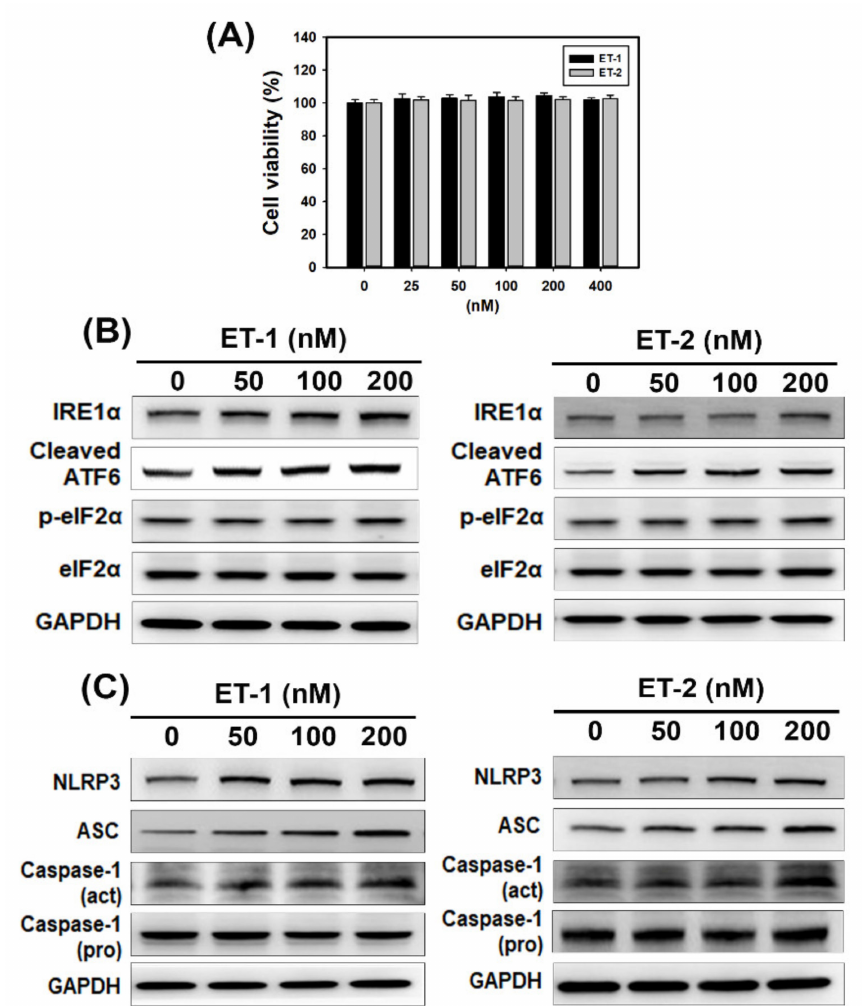
Figure 2. Cell viability, endoplasmic reticulum (ER) stress and the NLRP3 inflammasome in HK-2 cells treated with ET-1 or ET-2. ( A ) Cell viability of ET-1- or ET-2-treated HK-2 cells. Data were presented as the means ± standard deviation of three independent experiments. ( B ) Western blot analysis of ER stress-associated protein expression in HK-2 cells. ( C ) Western blot analysis of NLRP3 inflammasome-associated protein expression in HK-2 cells. Cells were treated with various concentrations of ET-1 or ET-2 for 24